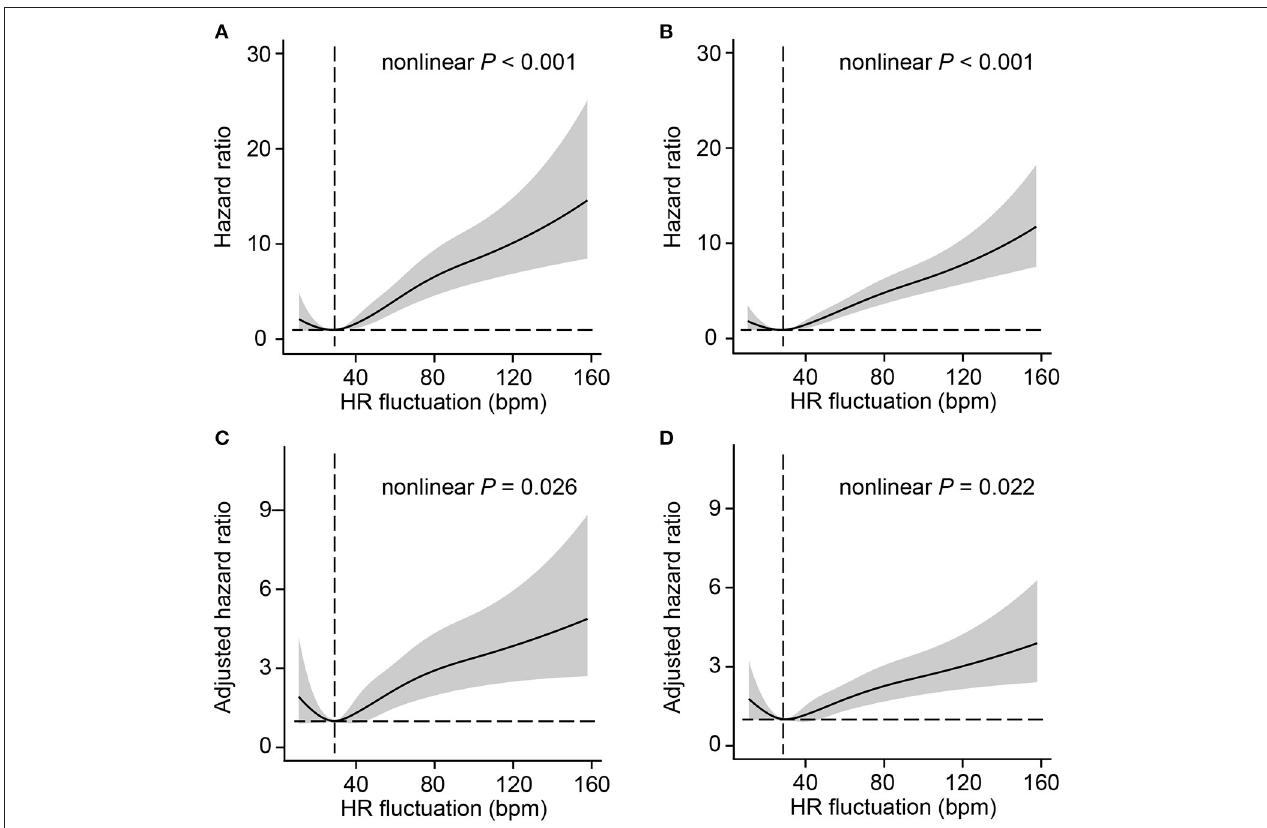
FIGURE 1 | Association between HR fluctuation and outcomes of MI patients. Crude hazard ratio and 95% CI for HR fluctuation in 30-day mortality (A) and 1-year mortality (B) . Adjusted hazard ratio and 95% CI for HR fluctuation in 30-day mortality (C) and 1-year mortality (D) . The analyses used a model with restricted cubic splines. The reference (hazard ratio = 1, horizontal dotted line) was an HR fluctuation of 30 bpm (vertical dotted line). Adjusted variables included age, male sex, weight, SOFA score, admission HR, sedative use, ventilation use, vasopressor use, CHF, AF, hypertension, and liver disease, namely, model 5 described above. HR, heart rate; SOFA, sequential organ failure assessment; CHF, congestive heart failure; AF, atrial fibrillation; CI, confidence